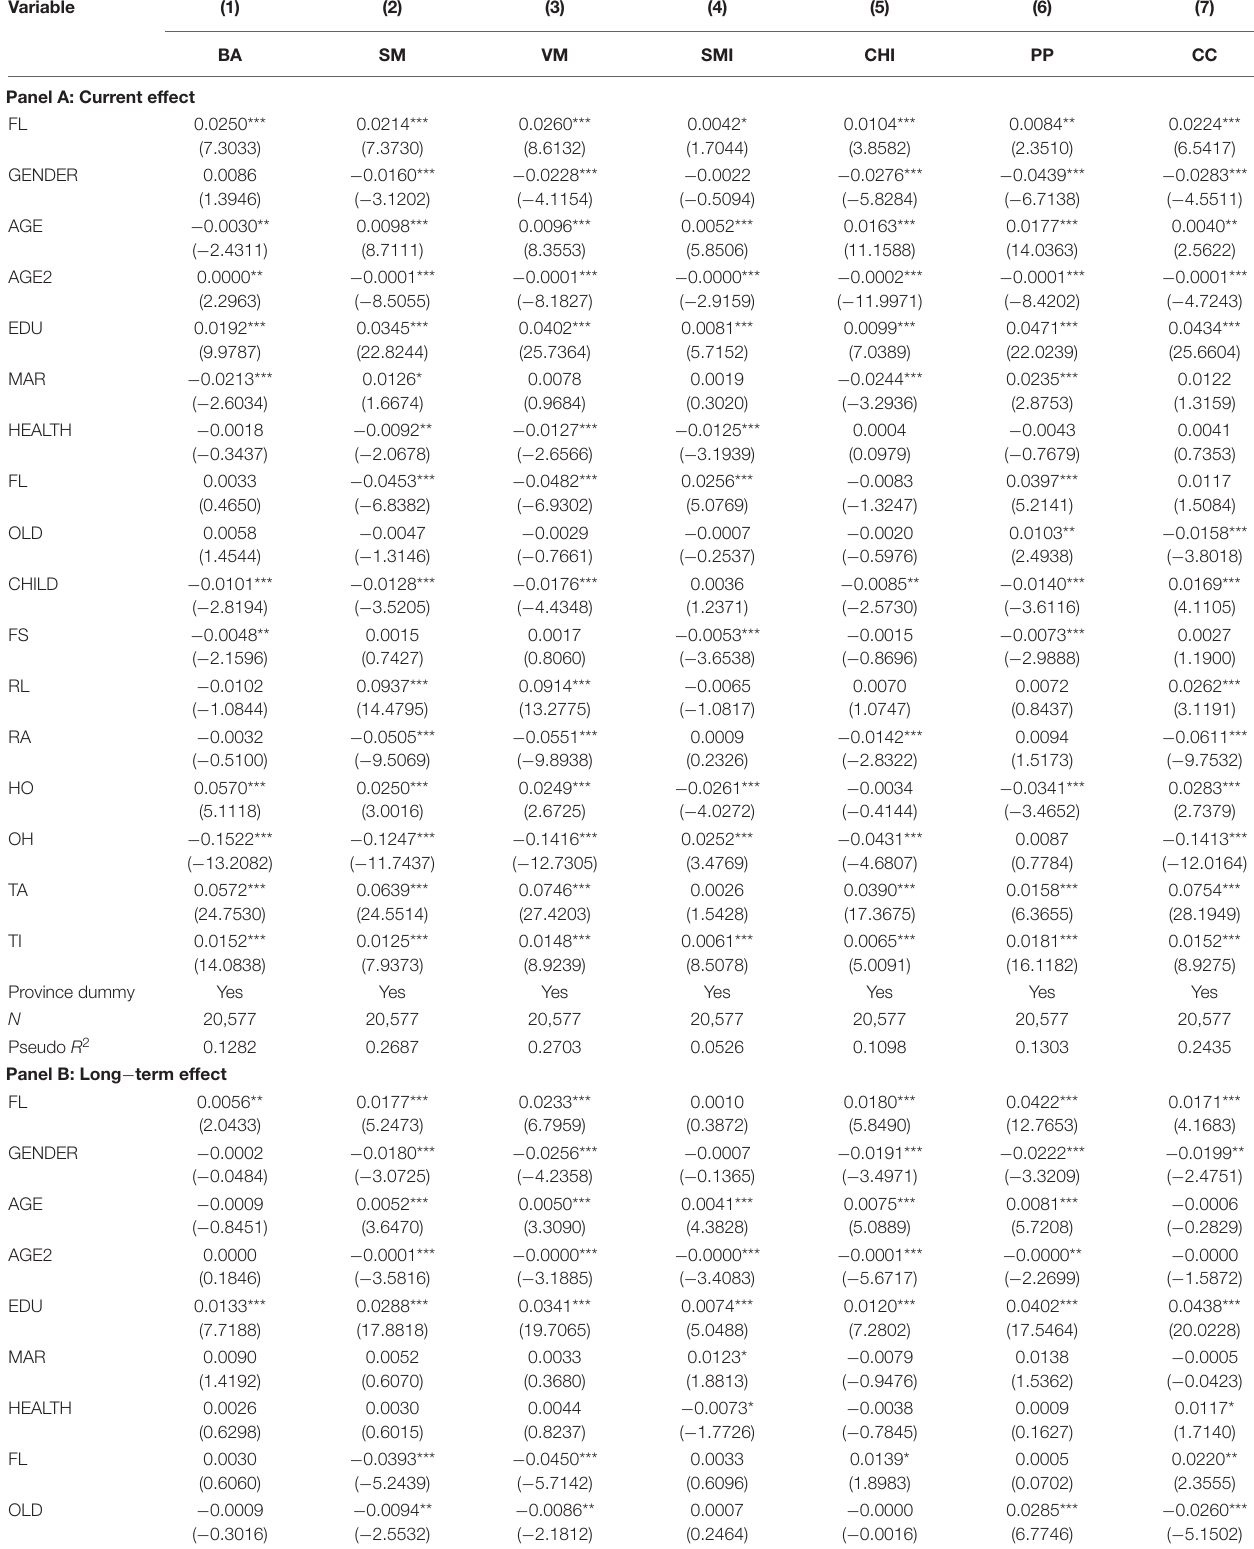
TABLE 3 | The impact of financial literacy on financial